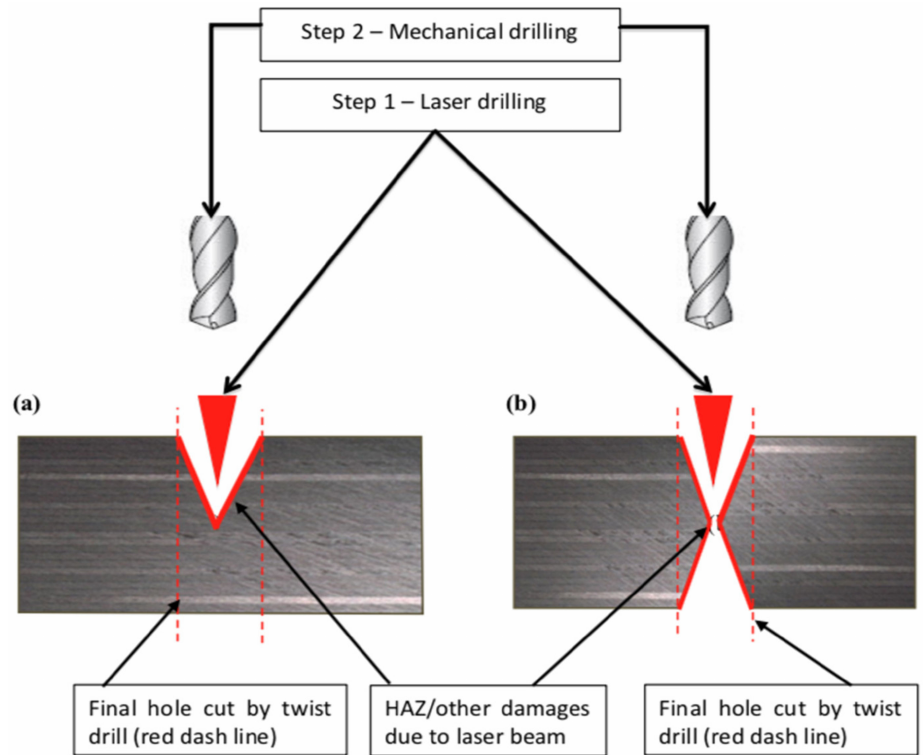
Figure 3. Illustration of sequential laser and mechanical drilling: ( a ) laser pre-drill on one side; and ( b ) laser pre-drill on both